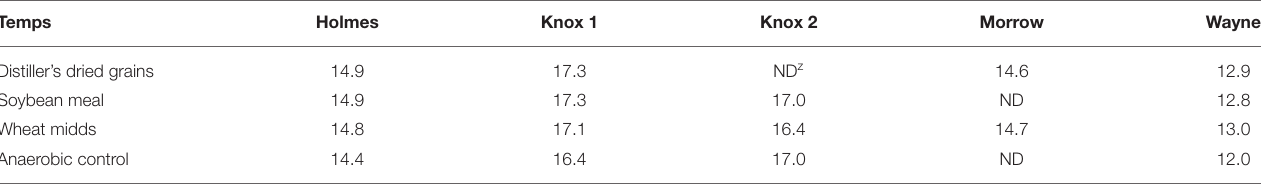
TABLE 3 | Average soil temperatures ( ◦ C) during anaerobic soil disinfestation treatment in on-farm trials assessing distiller’s dried grains, soybean meal, and wheat midds as carbon sources (20.2 Mg/ha).